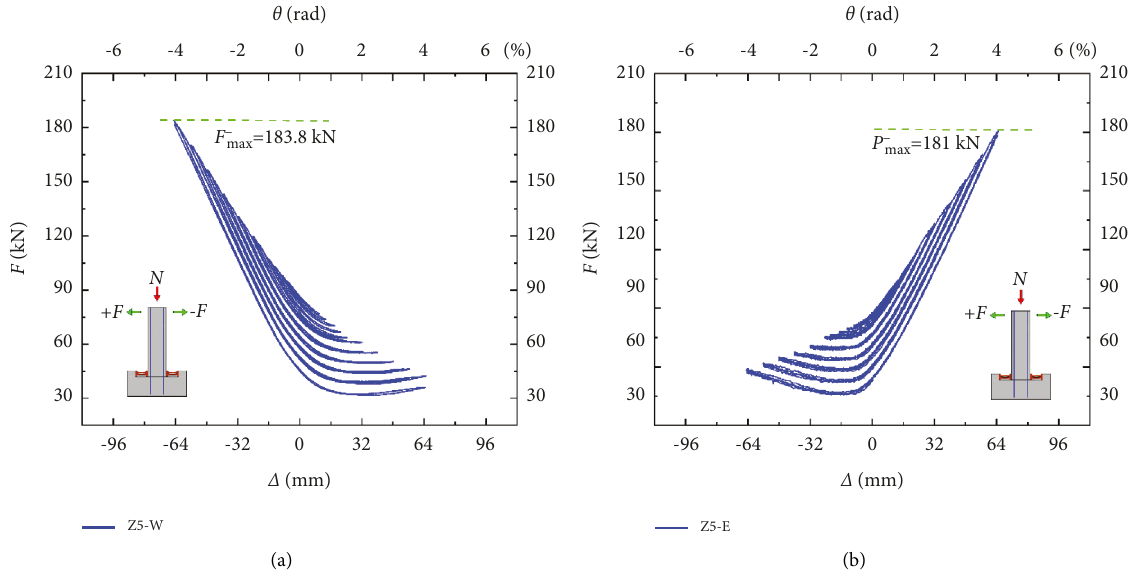
Figure 15: Stiffness degradation curves (1/25). (a) K-Δ ; (b) K